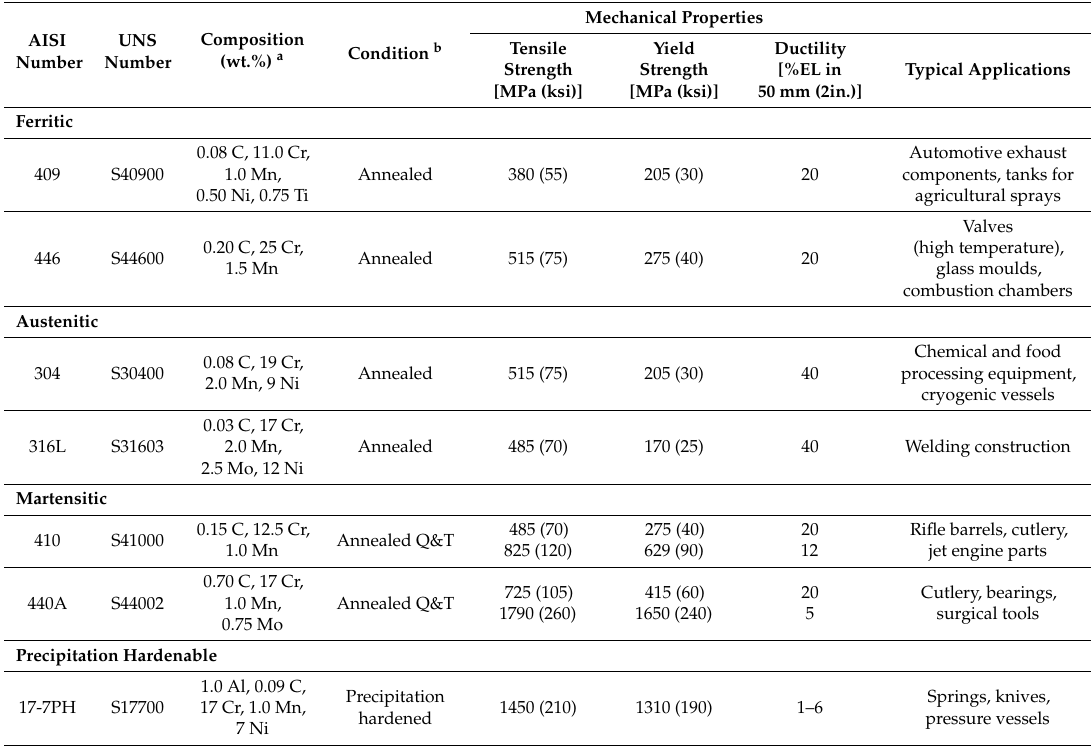
Table 1. Designations, compositions, mechanical properties and typical applications for austenitic, ferritic, martensitic and precipitation-hardenable stainless steels [7].